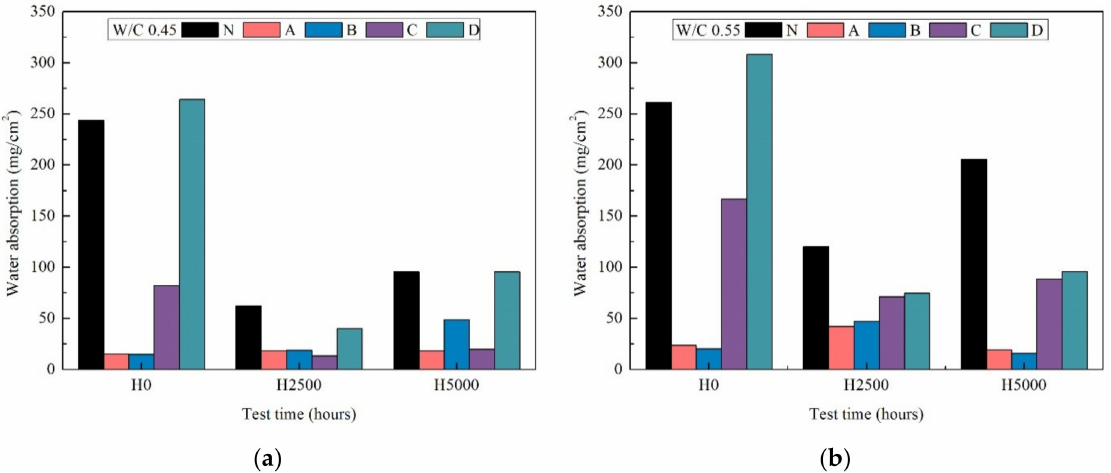
Figure 7. Water absorption test according to Japan Standard NSKS-04 on uncoated and coated specimens of mortar at w/c ratios 0.45 ( a ) and 0.55 ( b